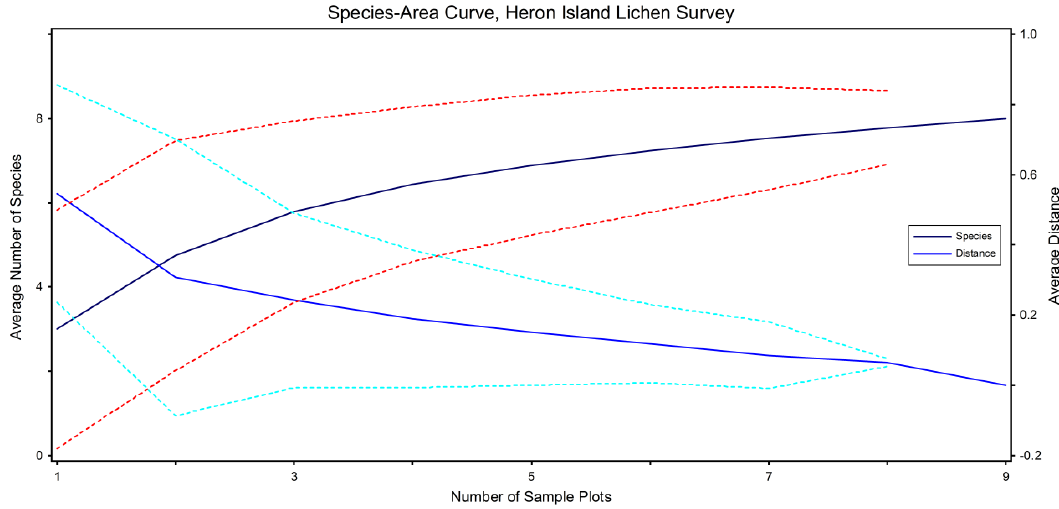
Figure S2. Species-Area Curve for number of plots required to capture complete lichen census at Heron Island, Australia. The asymptotic nature of the species curve (dark blue), as well as Sørensen distance curve (bright blue), describes a maximization of effort (number of plots) required to capture the complete epiphytic lichen flora of the survey area. Dotted lines represent ±1 standard deviation.